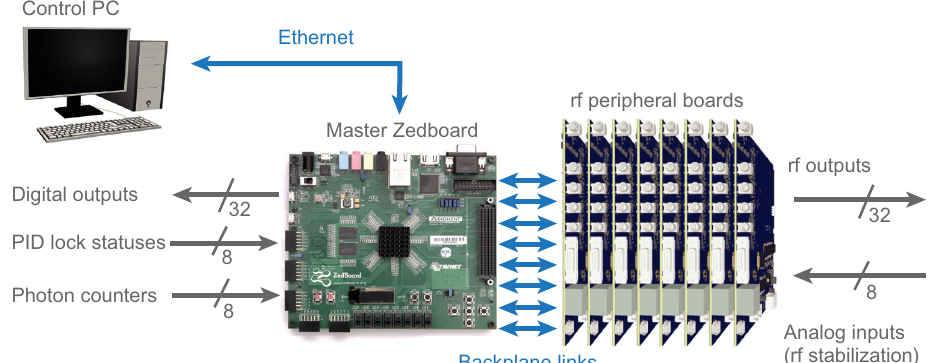
FIG. 9. M-ACTION exper- imental control system. The master board acts as the